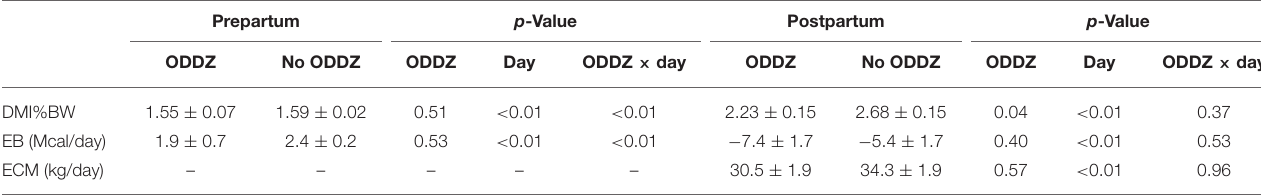
TABLE 6 | Association of pre- ( − 21 to − 1 day) and postpartum (1 to 28 days) dry matter intake as percentage of body weight (DMI%BW), energy balance (EB), and energy-corrected milk (ECM) with other digestion disorders (ODDZ) postpartum according to multivariable analysis.